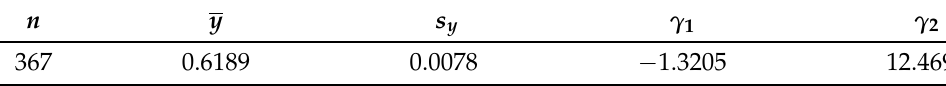
Table 8. Summary statistics for nitrogen concentration